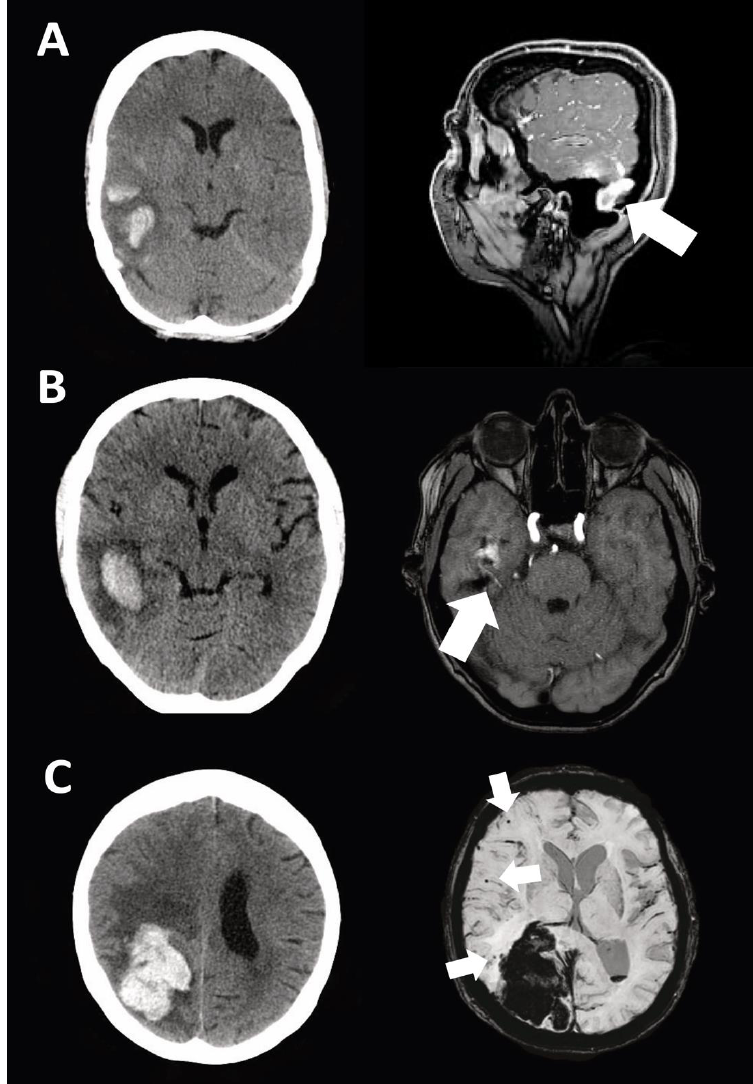
Figure 2. Exemplary cases with magnetic resonance imaging work-up for lobar ICH. ( A ) Lobar ICH caused by sinus venous thrombosis; ( B ) Lobar ICH caused by dural arteriovenous fistula; ( C ) Lobar ICH accompanied with underlying cerebral amyloid angiopathy (CAA). White arrow indi- cates the described pathology. In 9 out of 52 patients (17%) suffering from spontaneous lobar ICH, further histo- pathological investigation was performed after surgical biopsy or evacuation of ICH (see exemplary case studies in Figure 3).